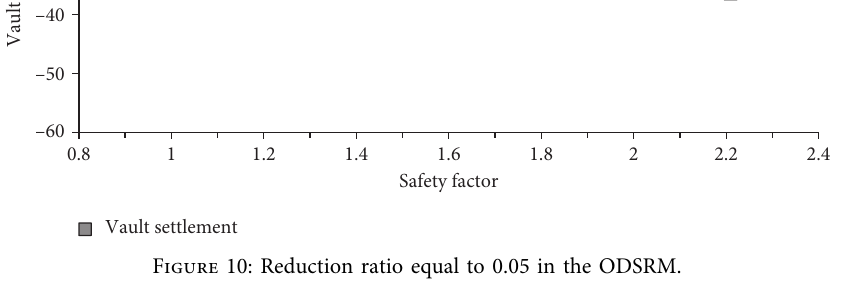
Figure 10: Reduction ratio equal to 0.05 in the ODSRM.